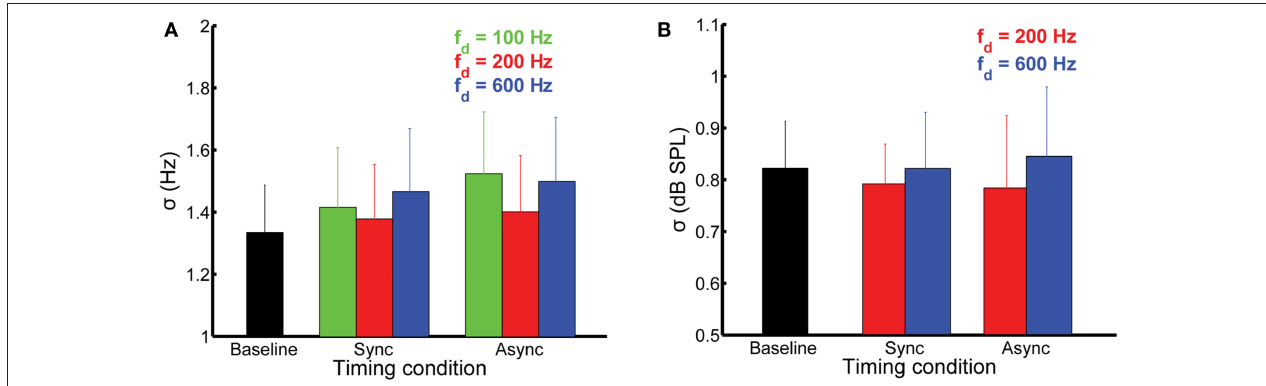
Figure S3 | Sensitivity estimates for the frequency and intensity discrimination tasks with timing manipulations. Error bars indicate SEM. (A) Timing experiments requiring frequency judgments. There were no significant main or interaction effects on sensitivity ( p > 0.05). (B) Timing experiments requiring intensity judgments. There were no significant main or interaction effects on sensitivity ( p >